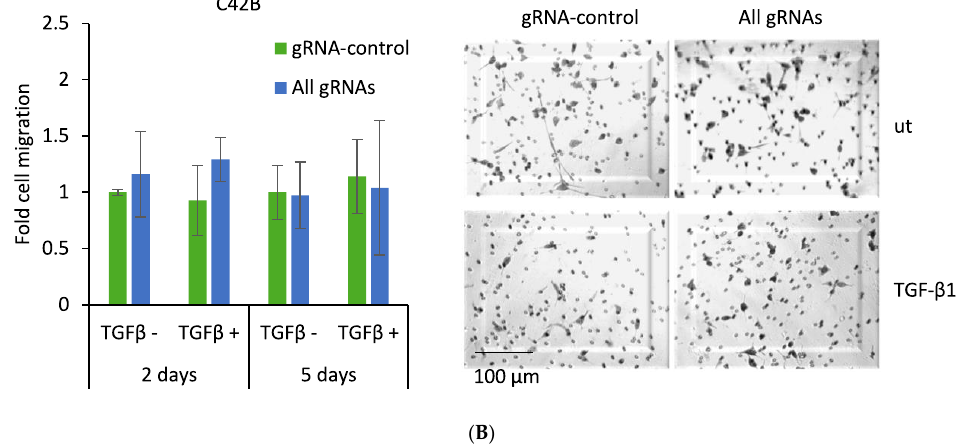
Figure 5. CRISPR-mediated induction of Dkk-3 reduces PC3 cell migration. PC3 and C4-2B cells transfected for one or four days with dCas9-VPR and either control (gRNA-control) or DKK3 (All gRNAs) gRNAs were plated in transwell inserts in serum-free medium ± 2 ng/mL TGF-β1 and allowed to migrate for 24 h. ( A , B ) Graphs show average fold change in cell migration (± TGF-β) for PC3 ( A ) and C4-2B ( B ) cells, 2 d or 5 d after transfection, relative to migration of untreated gRNA-control cells, ± SD of duplicate wells ( n = 3). * p < 0.05, two-tailed Student’s t -test. Representative images (5d) show migrated cells in the inserts stained with crystal violet, 200× magnification.